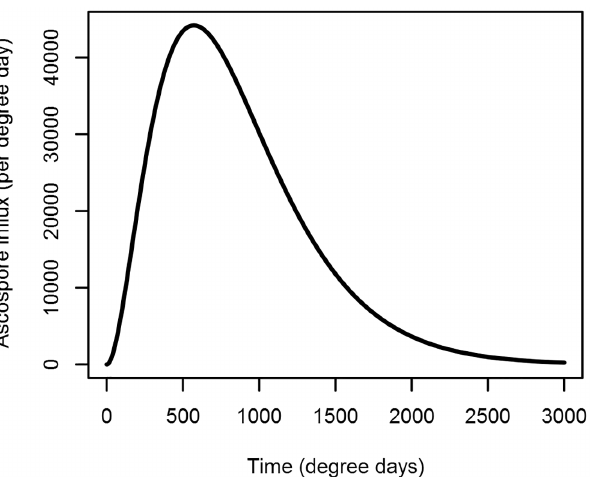
Fig 3. Seasonal ascospore spore concentrations. The peak of the function was during the winter (0 – 1200 degree days) and declined to 1% of the peak value at the time of death of leaf 5 (2094 degree